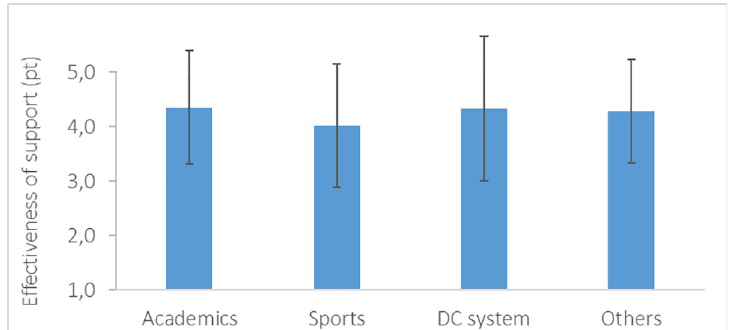
Fig 5. Mean and standard deviation of effectiveness of the financial support received by the migrating student- athletes.